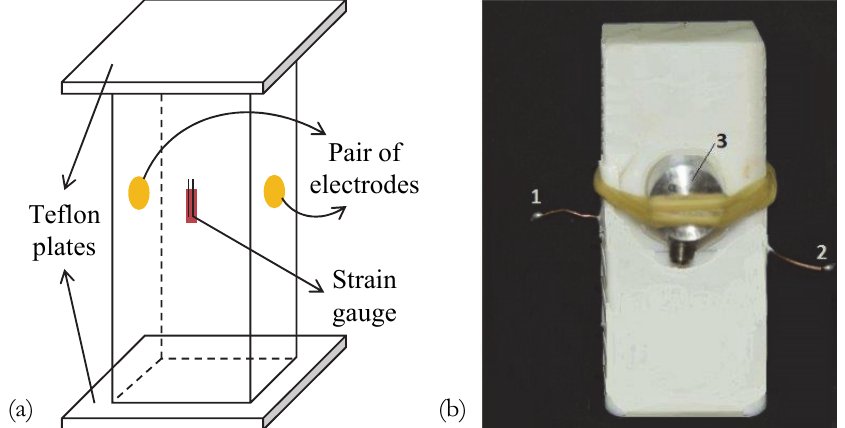
Figure 1: (a) A sketch of the experimental set up, (b) A typical marble specimen. The pair of electrodes (1, 2) and the acoustic sensor (3) are also